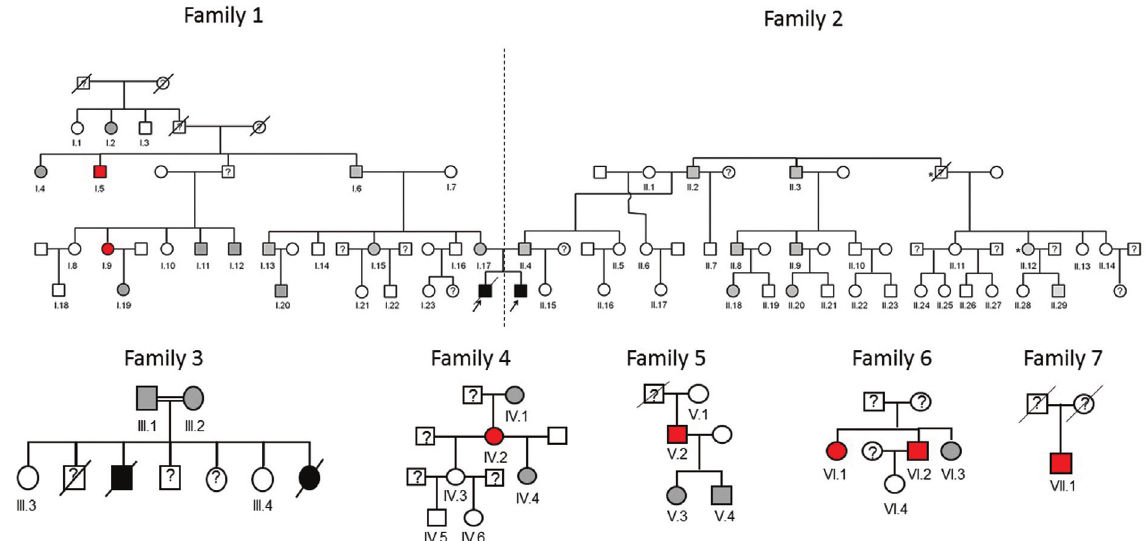
Figure 1 - The seven identified Brazilian families with STAT5B c.424_427del mutation. Homozygous patients are indicated by black symbols, heterozy- gouscarriersbygraysymbolsandnon-carriersbywhitesymbols.Redsymbolsrepresenttheindividualsidentifiedthroughanactivesearchforthismuta- tion in the city of Criciúma. The symbol * refers to two individuals with severe pulmonary disease of unknown etiology. In family 3, the diagnosis of homozygosityfor STAT5B c.424_427delmutationinthetwodeceasedsiblingswasinferredfromtheirclinicaldataandfromthefindingthattheirparents are heterozygous